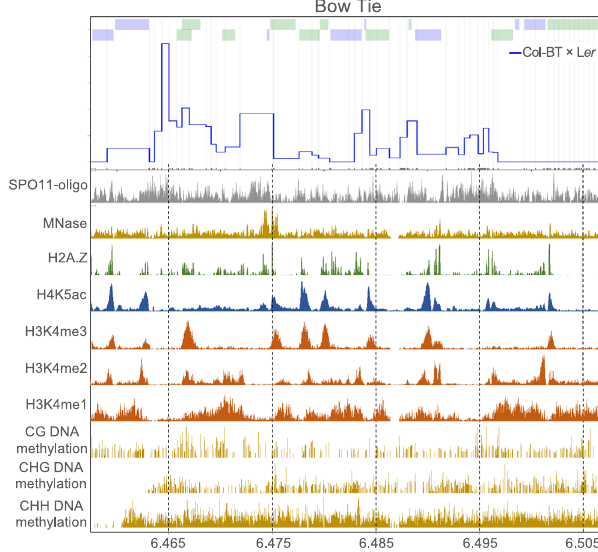
Fig. 7 | Chromatin landscape in the BTinterval. Histogramsshowing normalized coverage values for SPO11 − 1-oligonucleotides 85 , nucleosome occupancy (MNase- seq) 86 , H2A.Z 86 , H4K5ac 78 , H3K4me1/me3 87 , H3K4me2 88 , and DNA methylation (BSseq)inCG,CHG,andCHHsequencecontexts 89 werepresentedinrelationtoBT CO landscape for Col-BT × L er . Source data are provided as a Source Data fi